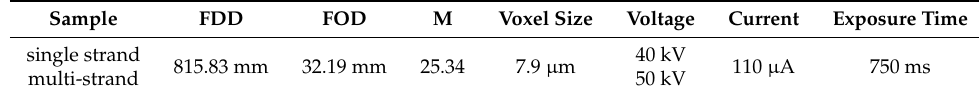
Table 1. XCT scan parameters for both the single- and multi-walled